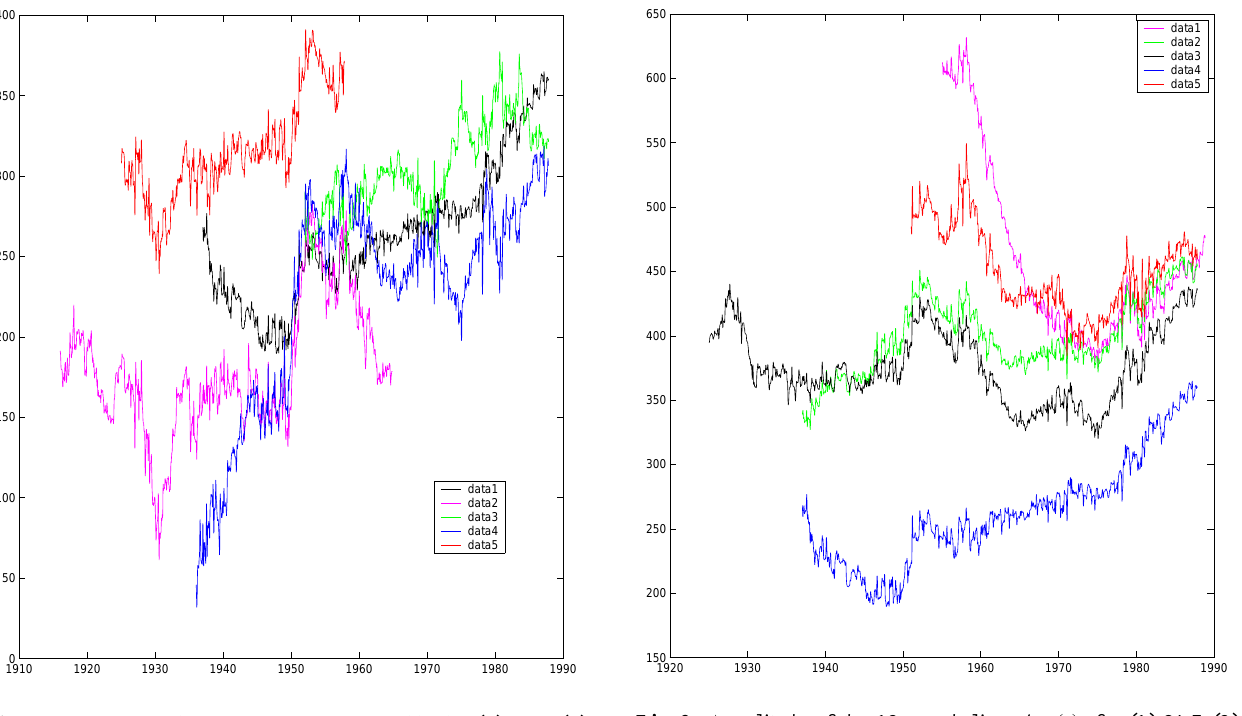
Fig. 8. Amplitude of the 12-month line, A 12 (t) , for (1) LER (2) HER (3) HON (4) KAK (5) TUC. X component. Vertical unit: .35 10 − 3 nT/day.